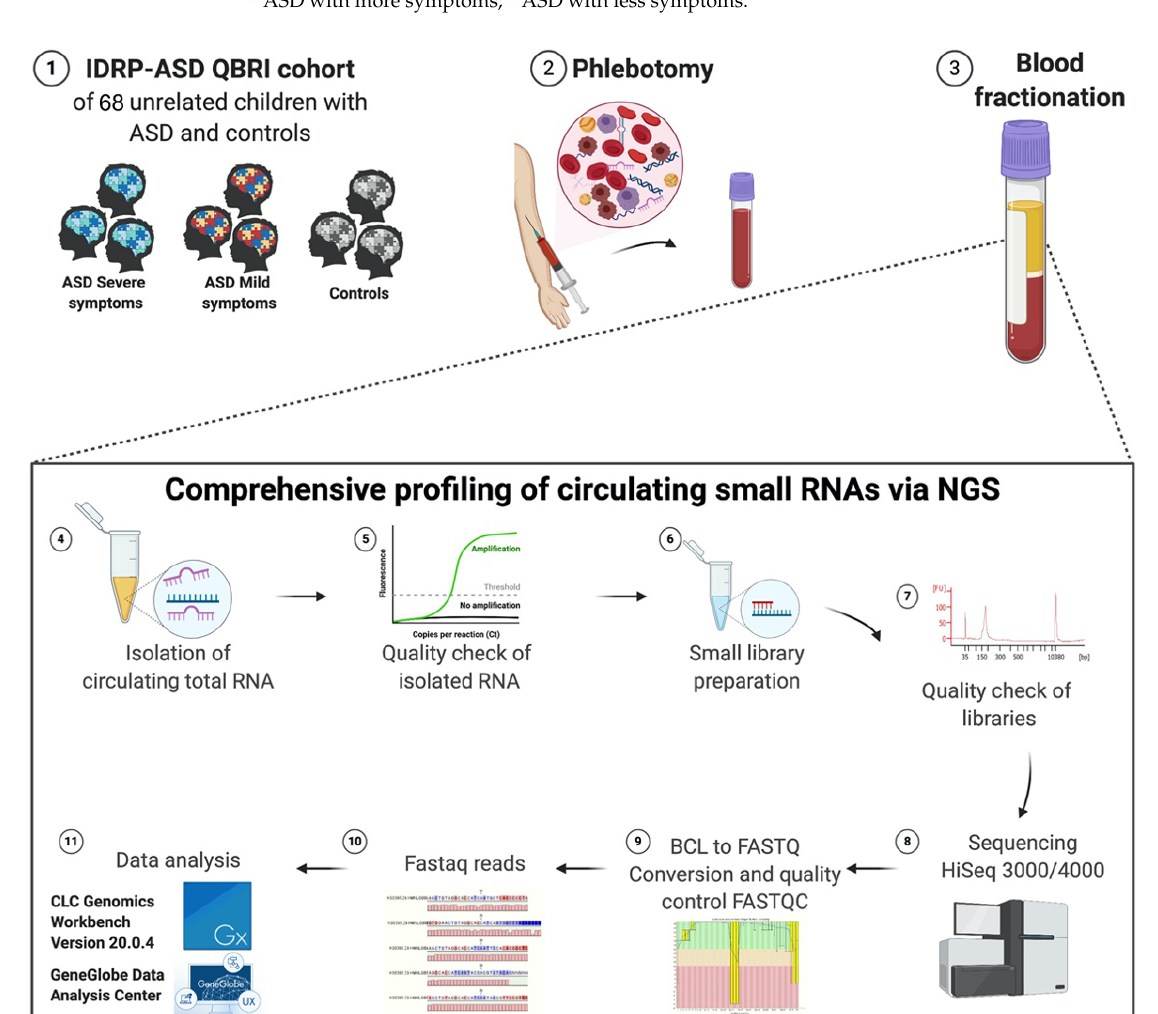
Table 1. Summary of cohort demographic characteristics.